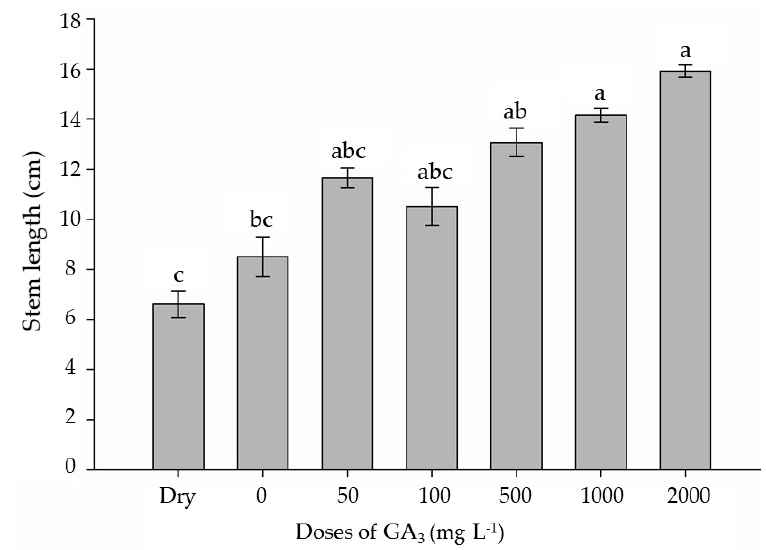
Figure 2. Stem length (cm) of C. Brasiliense tree seedlings from seeds stored for 40 days, pre-soaked in concentrations of GA 3 (mg L − 1 ) and dry seeds, without pre-imbibition, at 60 days after sowing in tubes. Equal letters represent equal averages and different letters represent different averages by the Tukey test at p < 0.05.